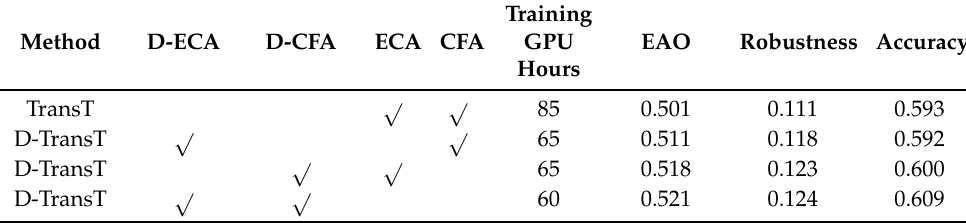
Table 5. Ablation study on